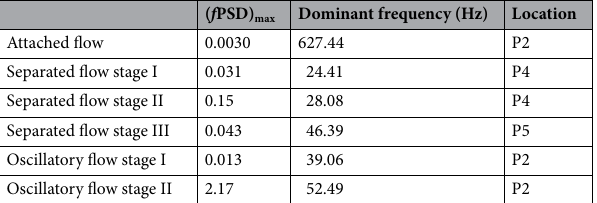
flow field at all frequencies. The contours of the flow field at the dominant frequency can be extracted to analyze the main oscillation structure and its spatial evolutionary relationship with the other regions. Power spectra analysis. The f PSD contours at the corresponding dominant frequency during the attached flow, separated flow and oscillatory flow are depicted in Fig. 11.